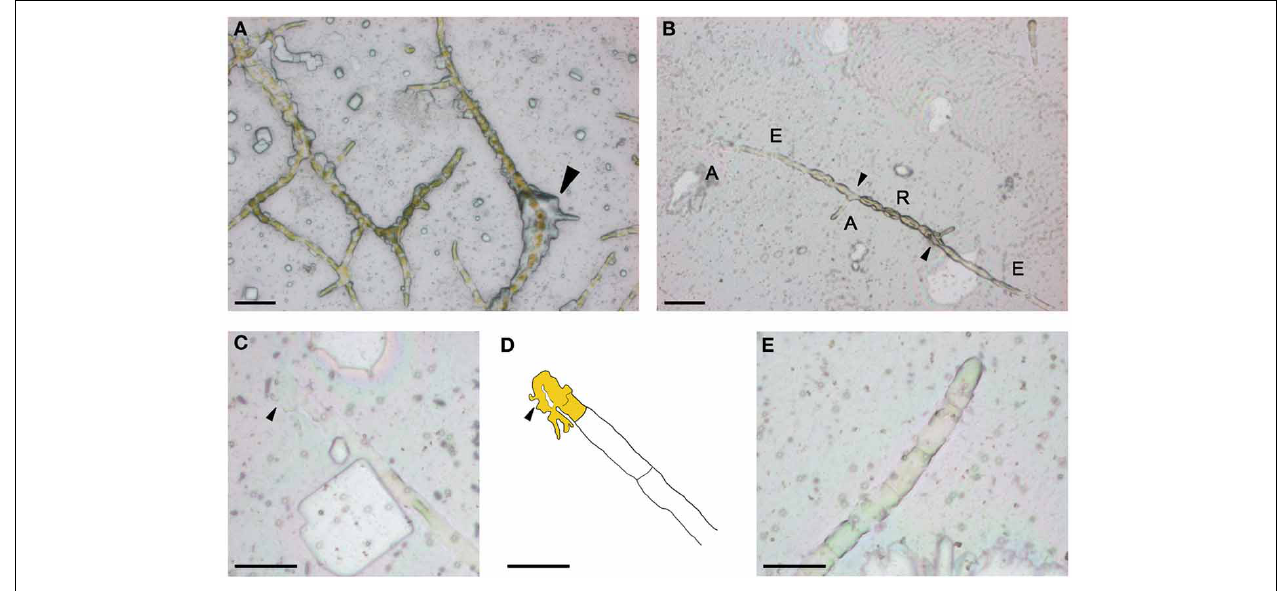
FIGURE 2 | On slide acetone fixation of Ectocarpus filaments. Filaments were fixed for 30min in acetone without (A) and with (B) a prewash in water. Close-up of a burst A-type cell (C) and its schematic (D) . General view of upright filaments (E) . A, A-type; E,